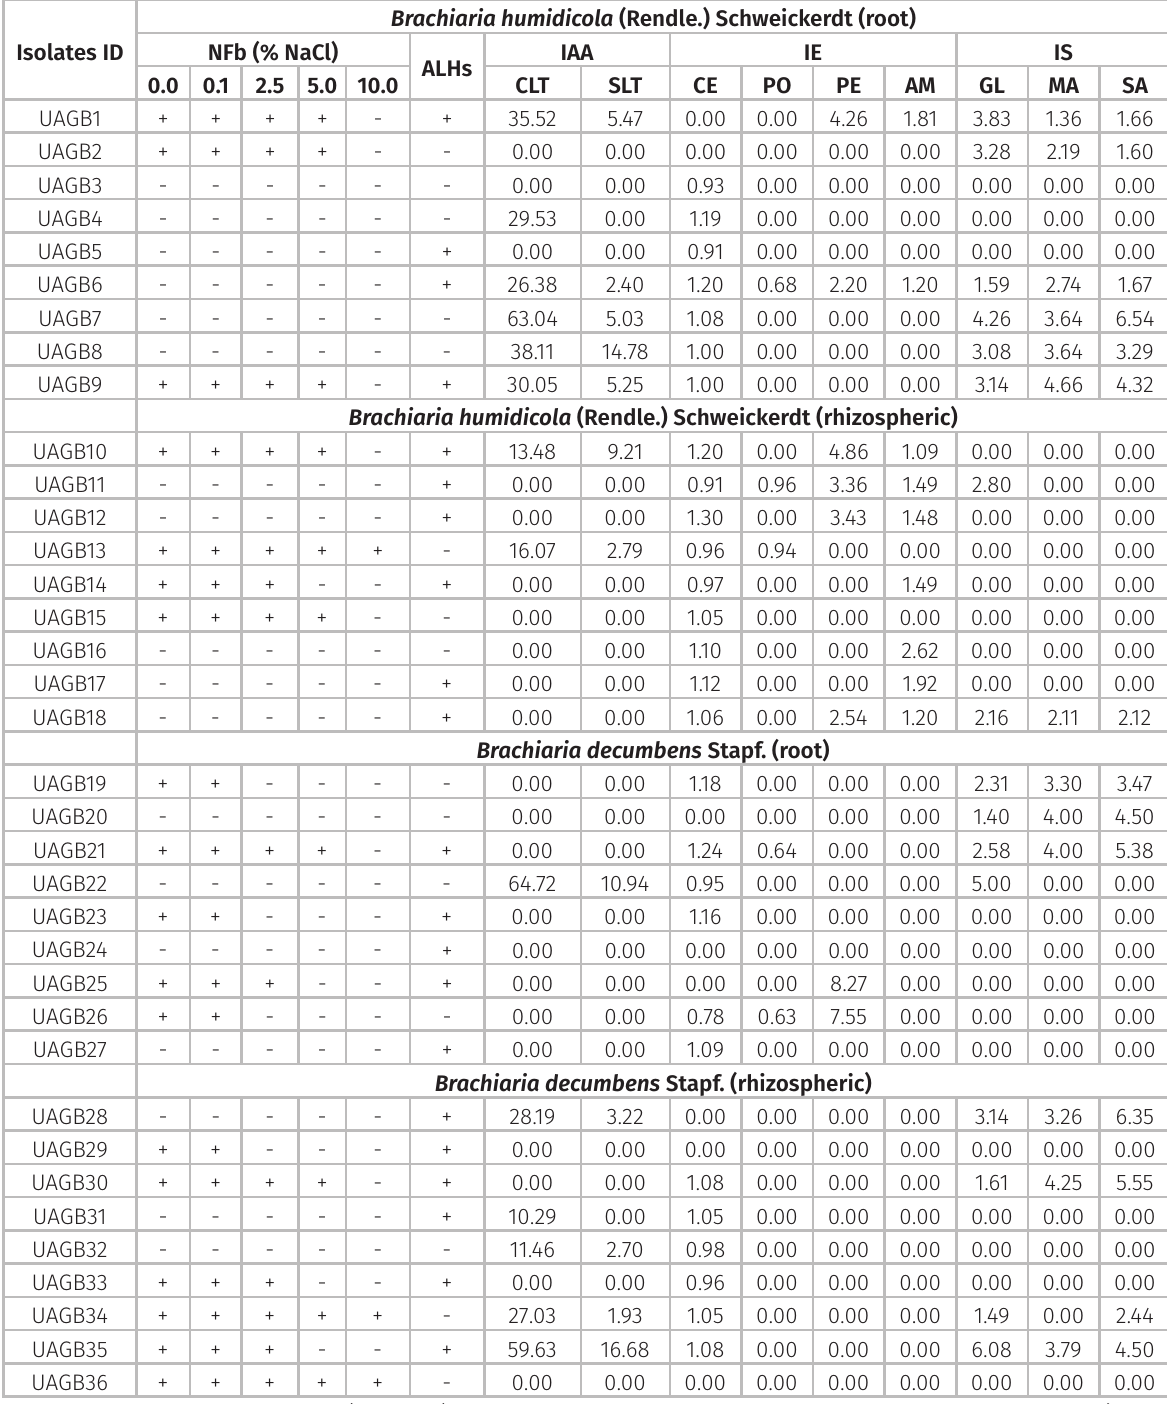
Table I. In vitro PGP mechanisms of the 36 bacterial isolates associated with Brachiaria humidicola (Rendle.) Schweickerdt and Brachiaria decumbens Stapf. in the root and rhizospheric niche. Brachiaria humidicola (Rendle.) Schweickerdt Isolates ID